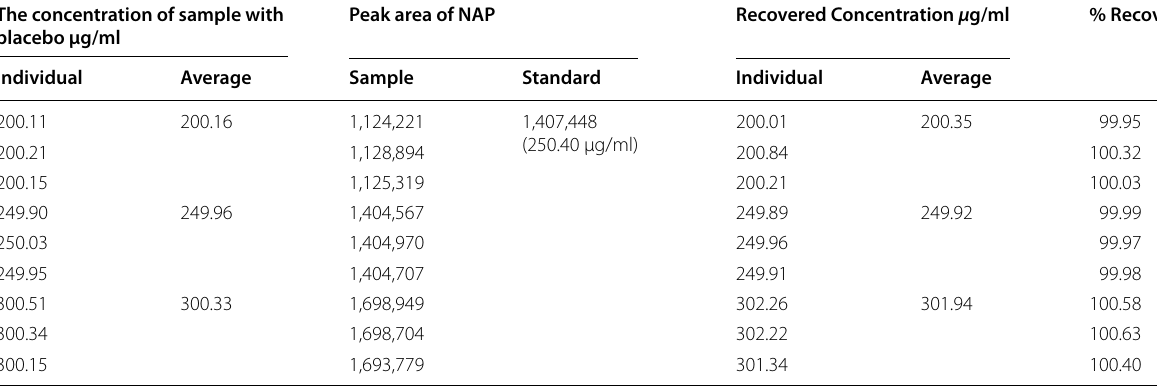
Table 4 Data of accuracy with placebo for recovery analysis for NAP